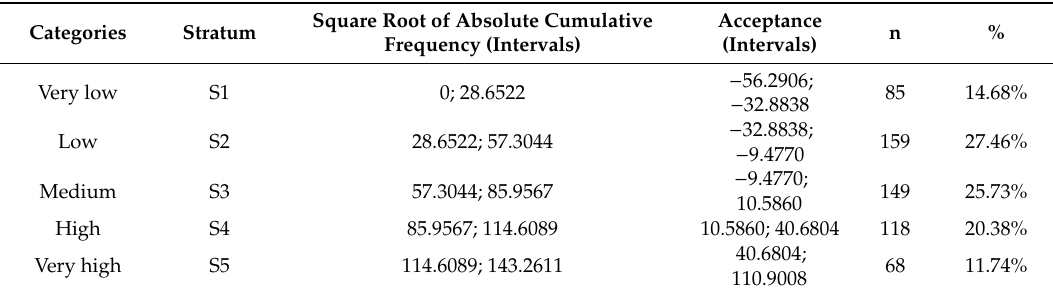
Table 10. Stratification of the acceptance